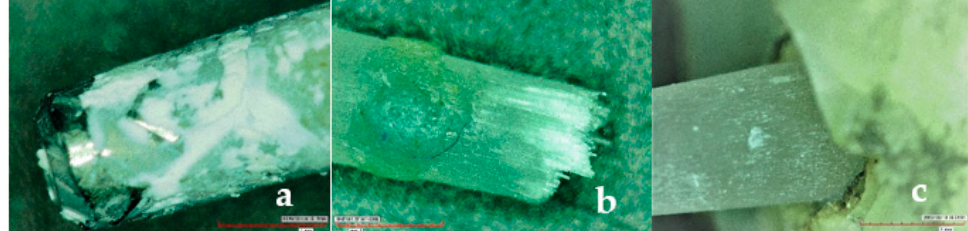
Figure 5. ( a ) Specimen with adhesive failure; ( b ) Specimen with cohesive failure; ( c ) Specimen with mixed type failure.